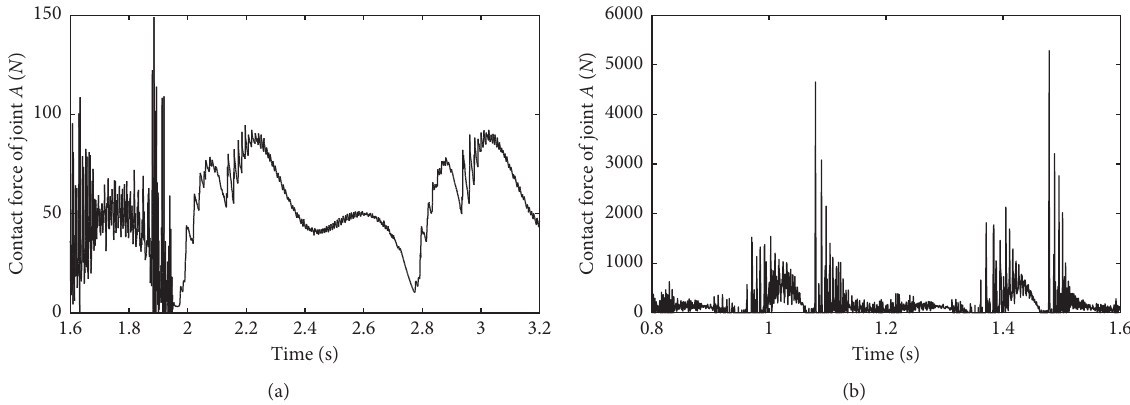
Figure 19: Contact force at pair A . (a) ω